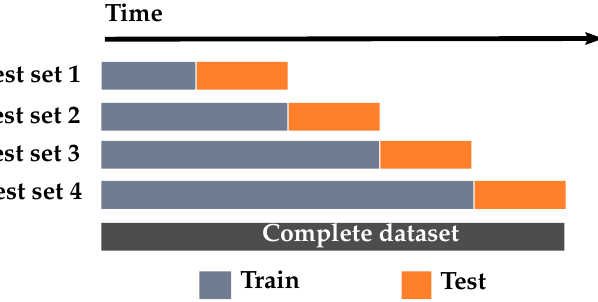
Figure 3. Illustration of the walk-forward validation technique. The test sets, indicated in orange, represent the validation weeks.